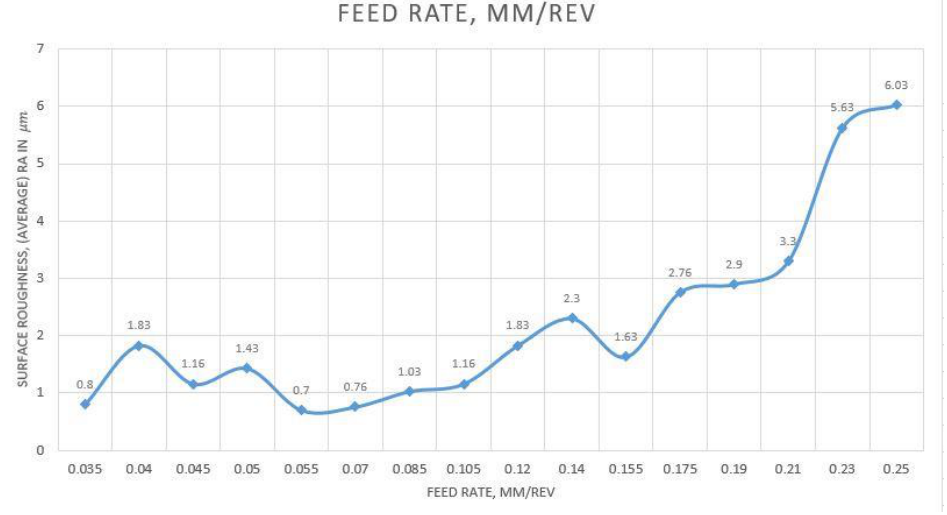
Figure 7: Feed rate and R a graph ( v = 80 m/min, d = 1.1 mm kept